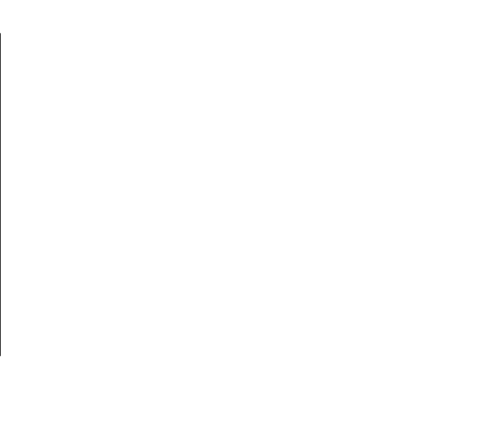
Figure 5. Luminescence intensity decay curves of PDI (red), GNPSi13-PDI (green), GNPSi9-PDI (yellow), GNPSi7-PDI (cyan) and SiNP-PDI (blue) nanoparticles using λ exc = 460 nm, with emission observed at 530 nm.